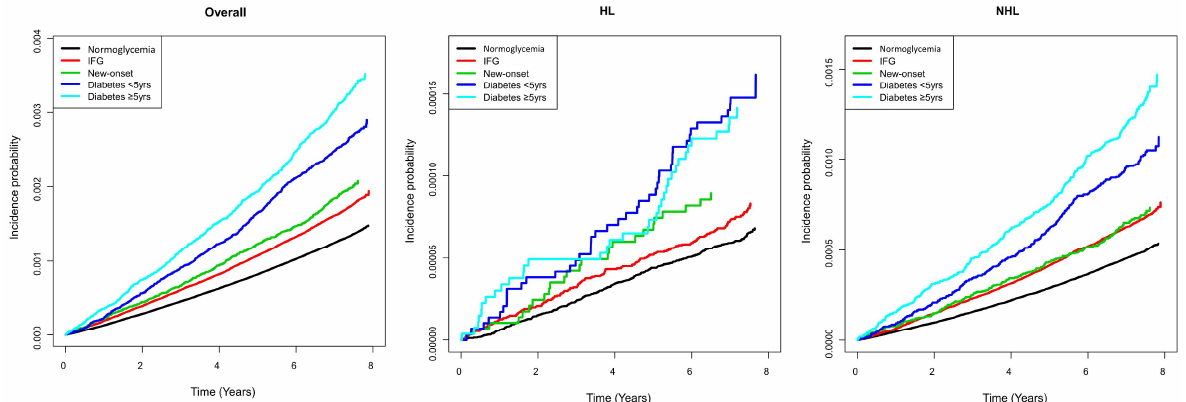
Figure 2. Cumulative incidence of the overall hematologic malignancy, Hodgkin’s lymphoma, and non-Hodgkin’s lym- phoma, according to the baseline glycemic status. IFG, impaired fasting glucose; HL, Hodgkin’s lymphoma; NHL, non-Hodgkin’s lymphoma. Table 3. The risk of hematologic malignancies according to the glycemic status and diabetes duration. Incidence Rate Subjects Duration Event ( n ) (per 1000 Model 1 Model 2 Subjects ( N ) Event ( n ) ( N ) (Person-Years) Person-Years) All Hematologic Malignancy 1